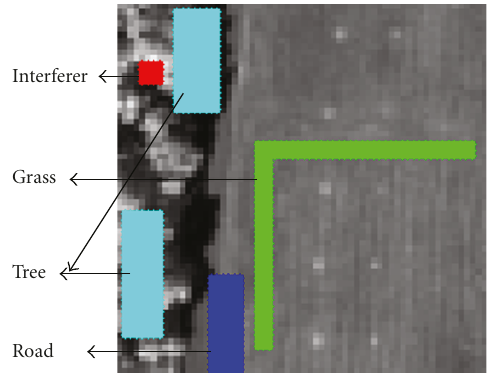
Figure 26: Four BKG classes obtained by marked